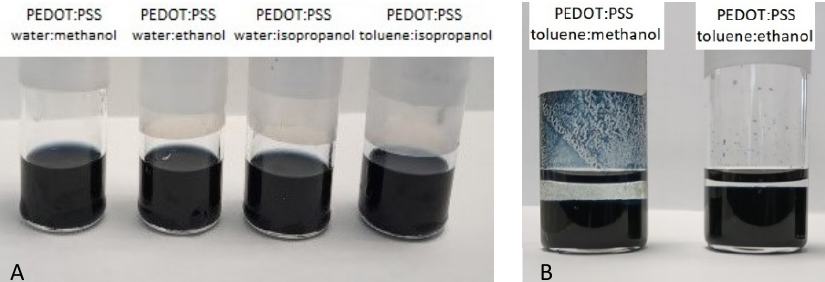
Figure 1. Poly(3,4-ethylenedioxythiophene:poly(styrenesulfonate) (PEDOT:PSS) in water or toluene mixed with different alcohols: methanol, ethanol, and isopropanol (( A )—stable mixtures, ( B )—unstable mixtures).